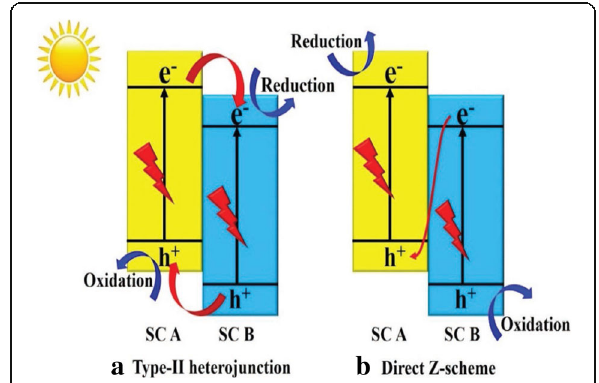
Fig. 5 A comparison of the charge transfer between type II heterojunction ( a ) and Z-scheme heterojunction ( b ). Reproduced with permission [3]. Copyright 2017 WILEY-VCH Verlag GmbH & Co.